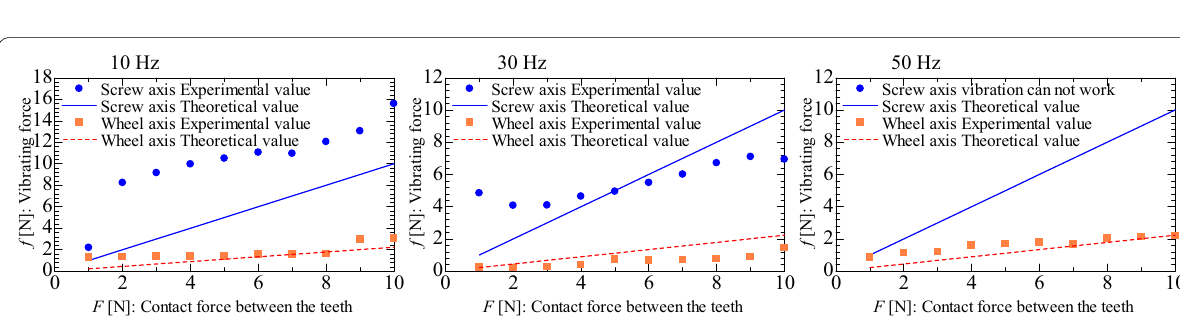
backdrivability easy. On the other hand, if the jump is small, the teeth become a single body without bounce.